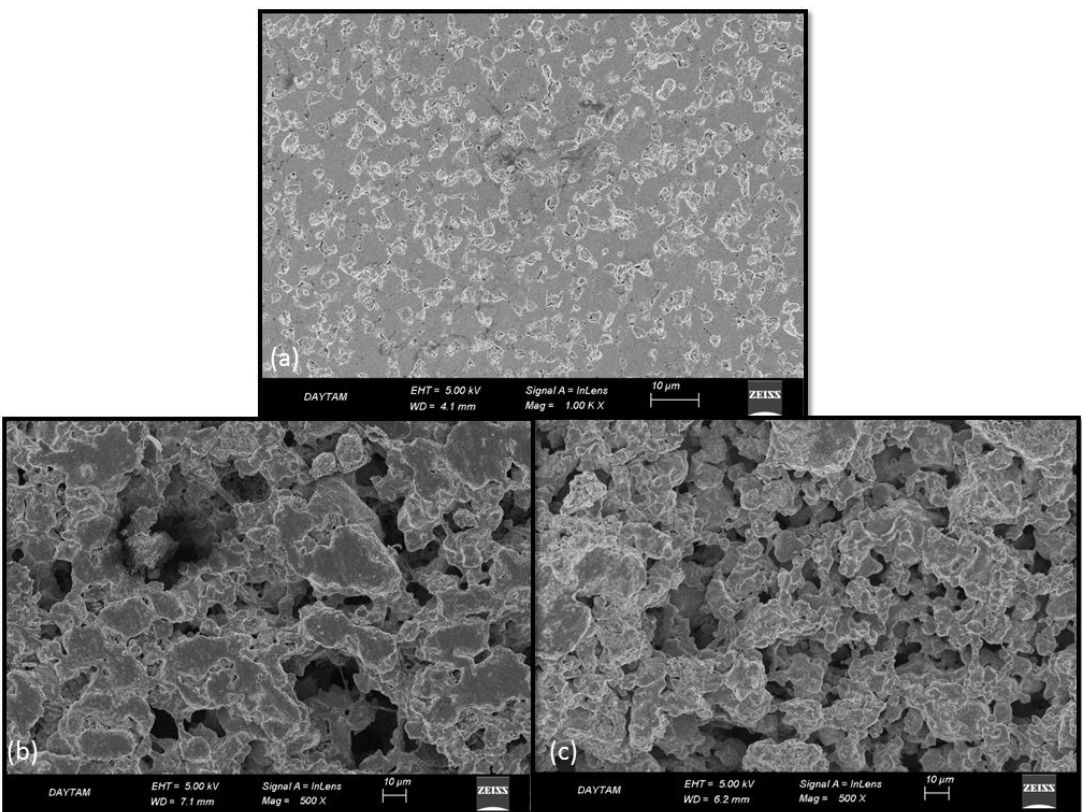
HCO added: a) Equimolar TiNbZr; b) 20 wt% 4 3